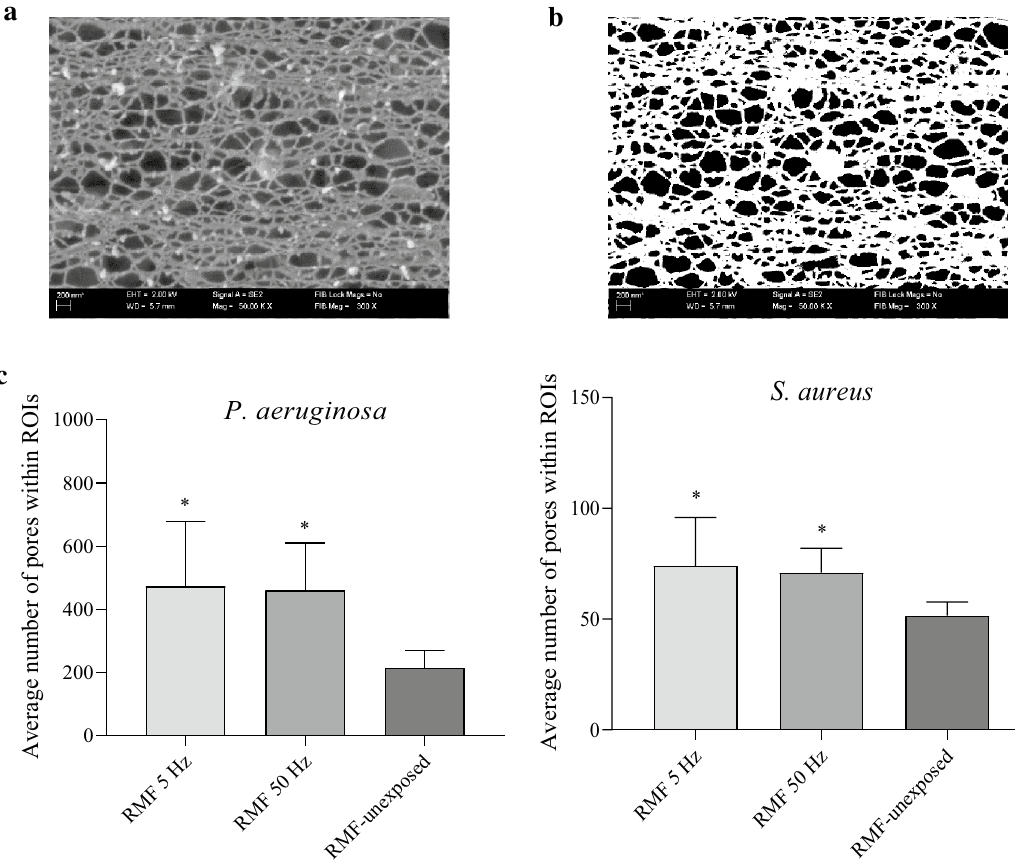
Figure 9. The porosity of biofilm matrix exposed and unexposed to RMF. ( a ) image of representative P. aeruginosa biofilm matrix, ( b ) image processing of matrix leading to differentiation of fibrils (white shapes) from matrix pores (black shapes), ( c ) average number of pores in S. aureus and P. aeruginosa biofilm matrix exposed and unexposed to RMF. The results are presented as mean ± SEM. The asterisks in graphs indicate statistical significance ( p < 0.05) between respective average values.